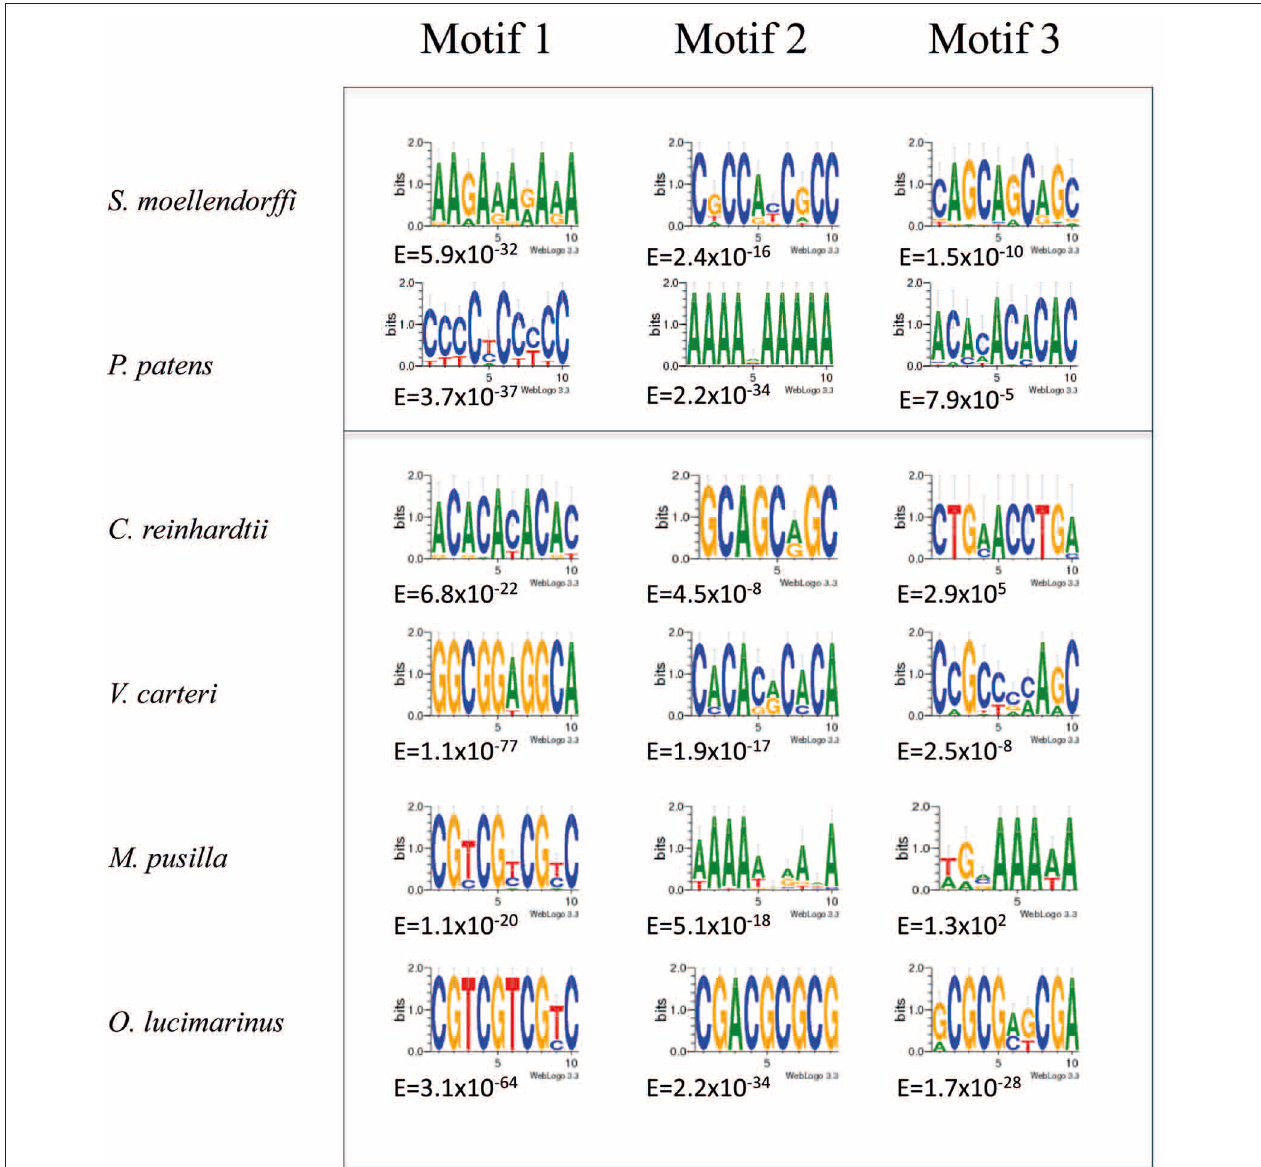
FIGURE 2 | MEME analysis of SETPHs from S. moellendorffii and P. patens (upper panel) and from chlorophytes (lower panel). Shown are the three overrepresented motifs in each promoter set identified by MEME analysis with the lowest Expectation (E) values below each motif.